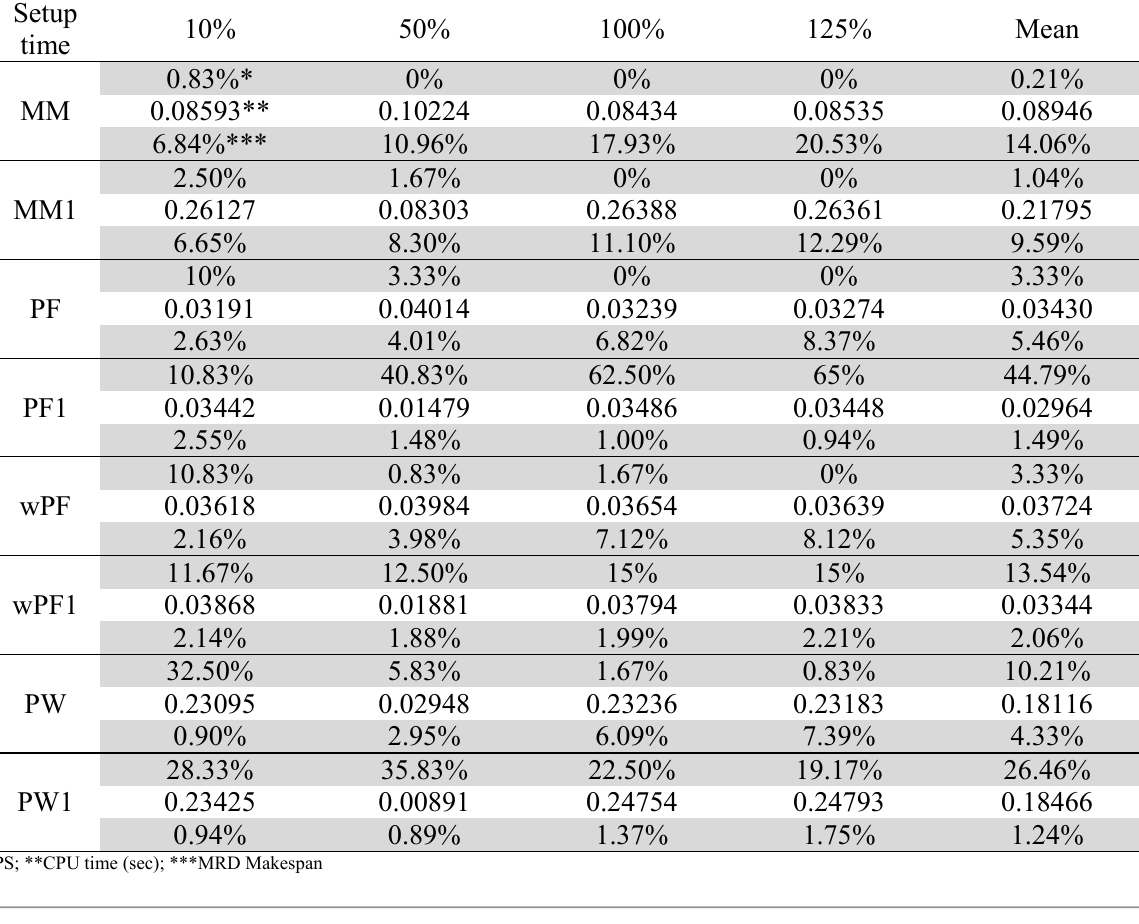
Performance of phase I heuristics Setup